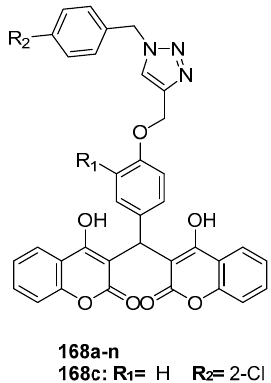
Figure 56. Chemical structure of biscoumarin-1,2,3-triazole hybrids. Substituents for compound 168c are reported.